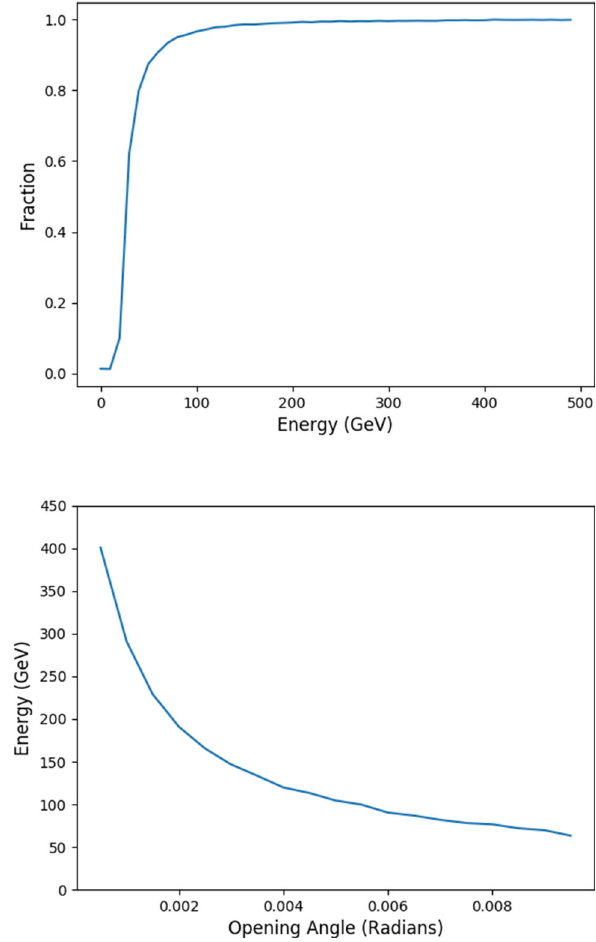
Fig. 5 The fraction of neutral pions passing an opening angle < 0.01 radianselectionatvariousparticleenergies(top).Themeanneutralpion energy as a function of opening angle